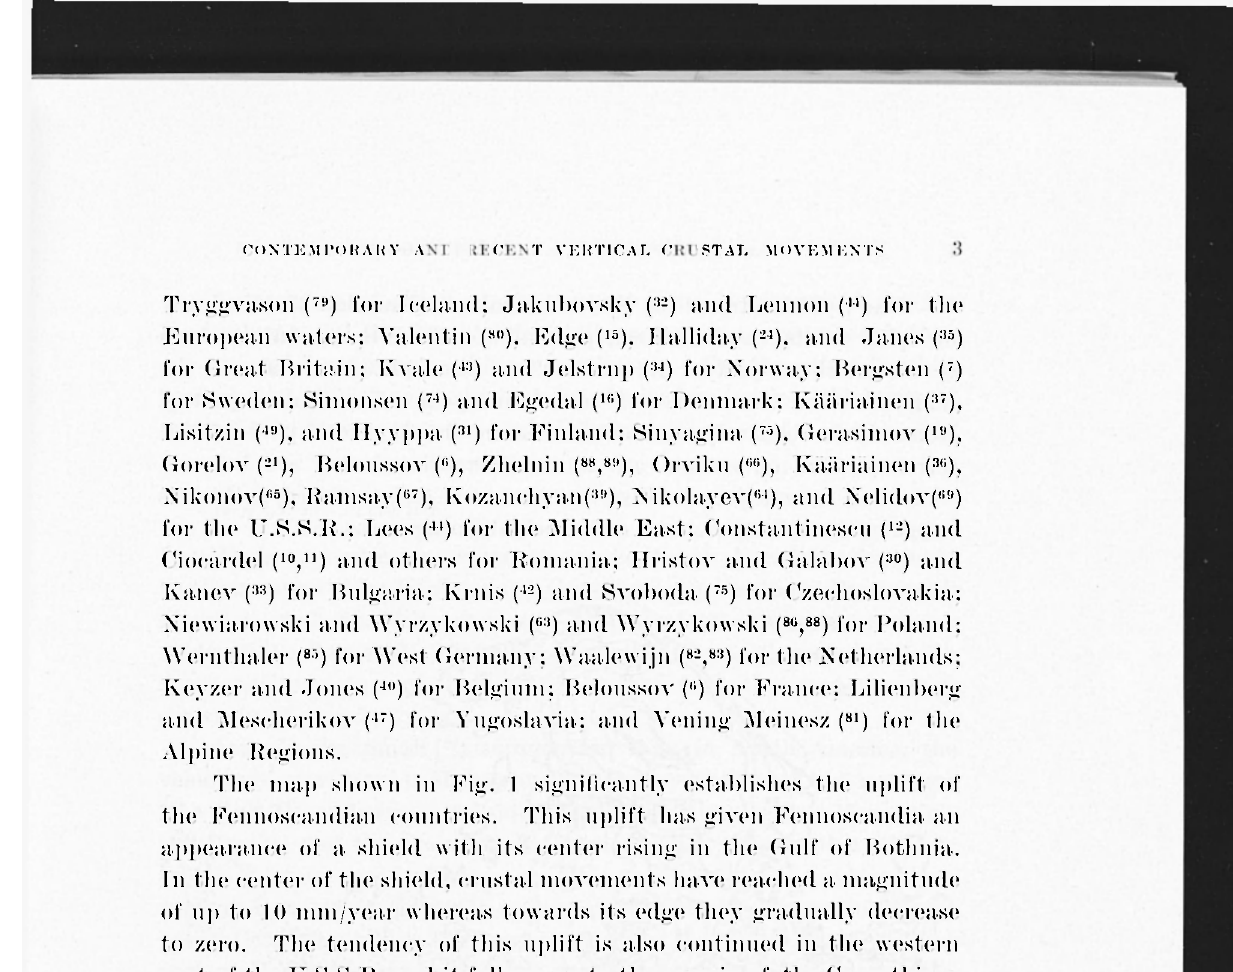
Tryggvason ( 7!l ) for Iceland: Jakubovsky ( 32 ) and Lennon (•'•') for